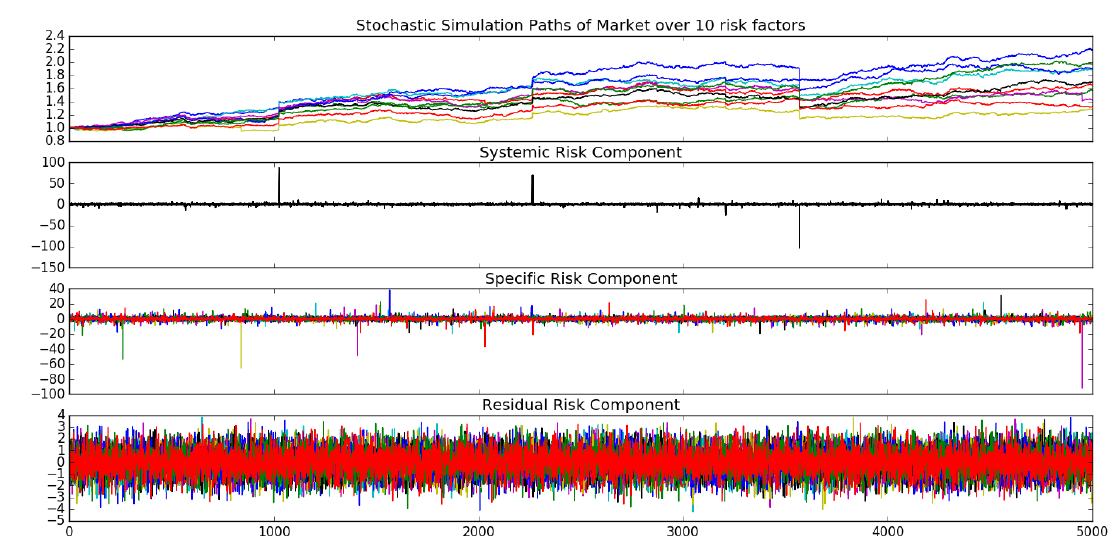
Figure 3. Stochastic Process Simulation of